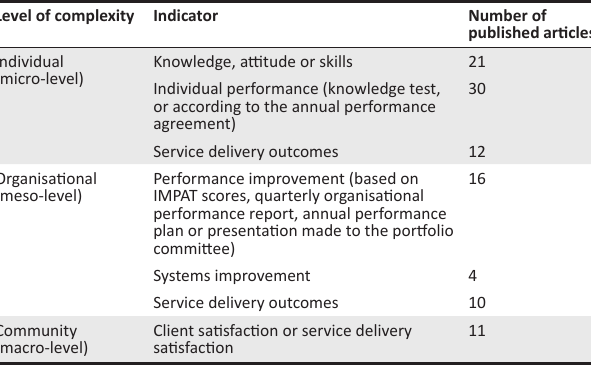
TABLE 2: Training evaluation outcomes based on a systematic review of relevant published